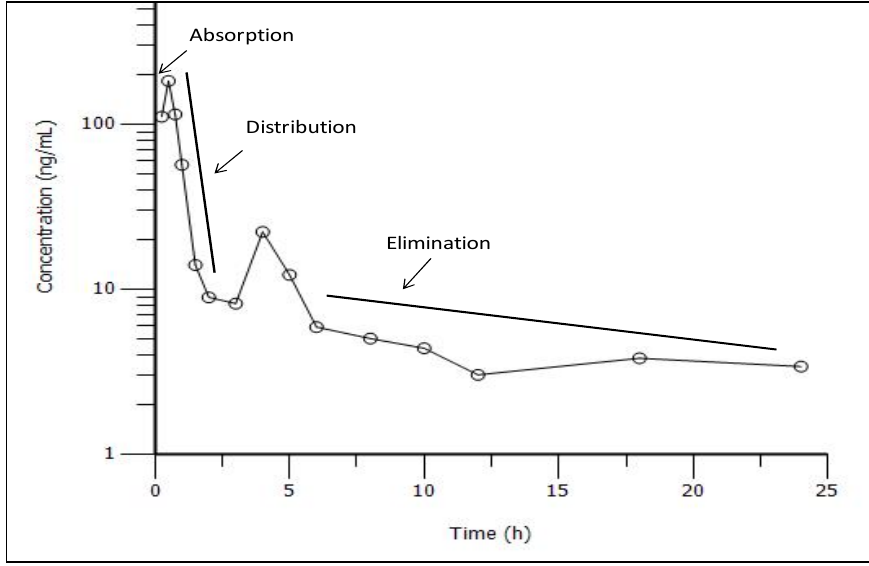
Figure 4. Log transformed plasma concentration profile of CRM-LF showing the absorption phase and rapid distribution phase followed by the slower elimination